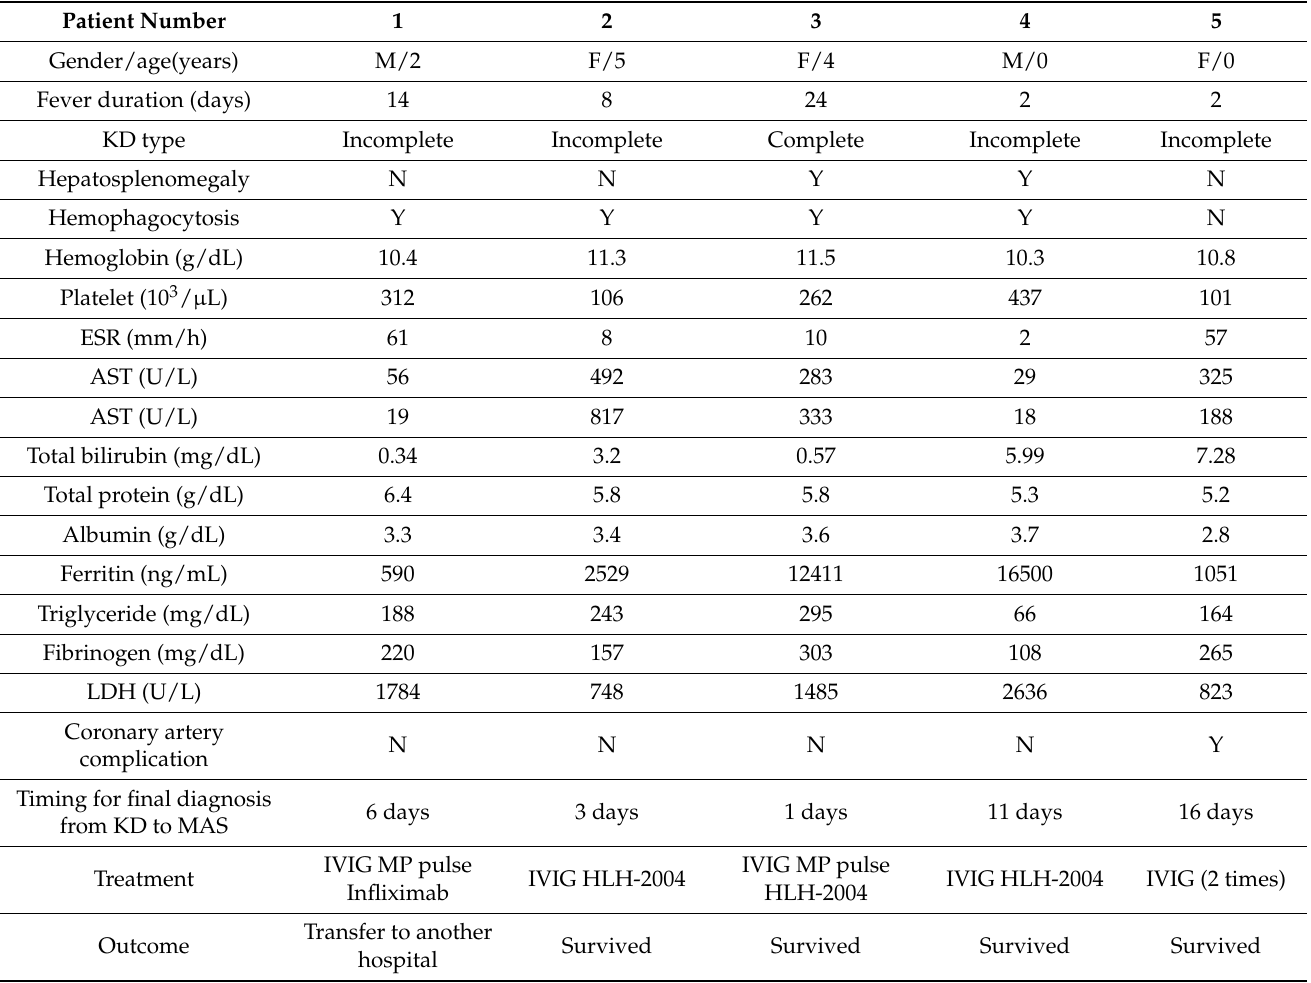
Table 4. Clinical and laboratory profiles of patients with